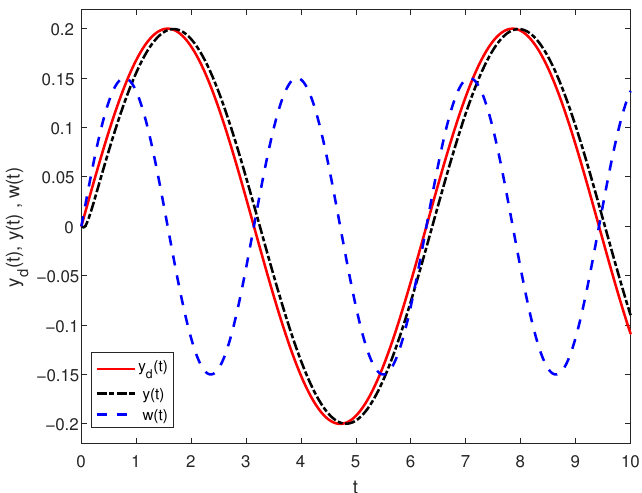
Figure 2. Output response by controller (42).